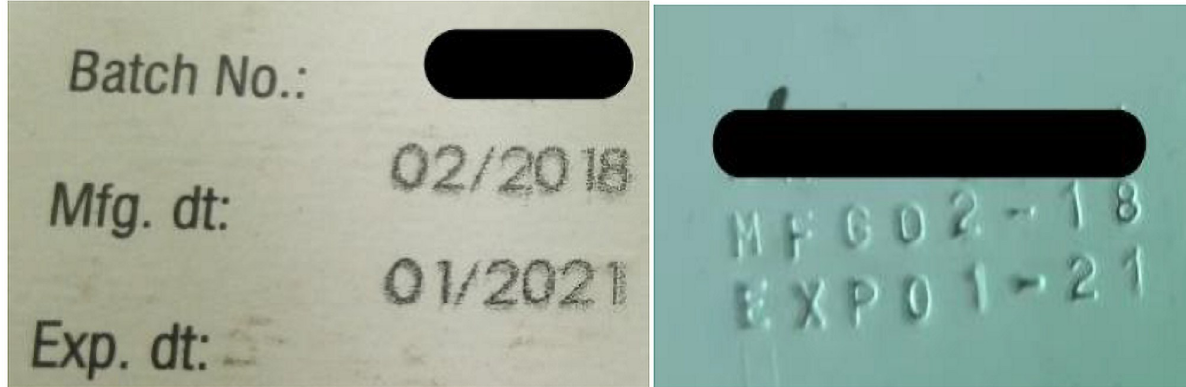
Fig 3. Labels of samples with same batch number of different printing style (Ink and